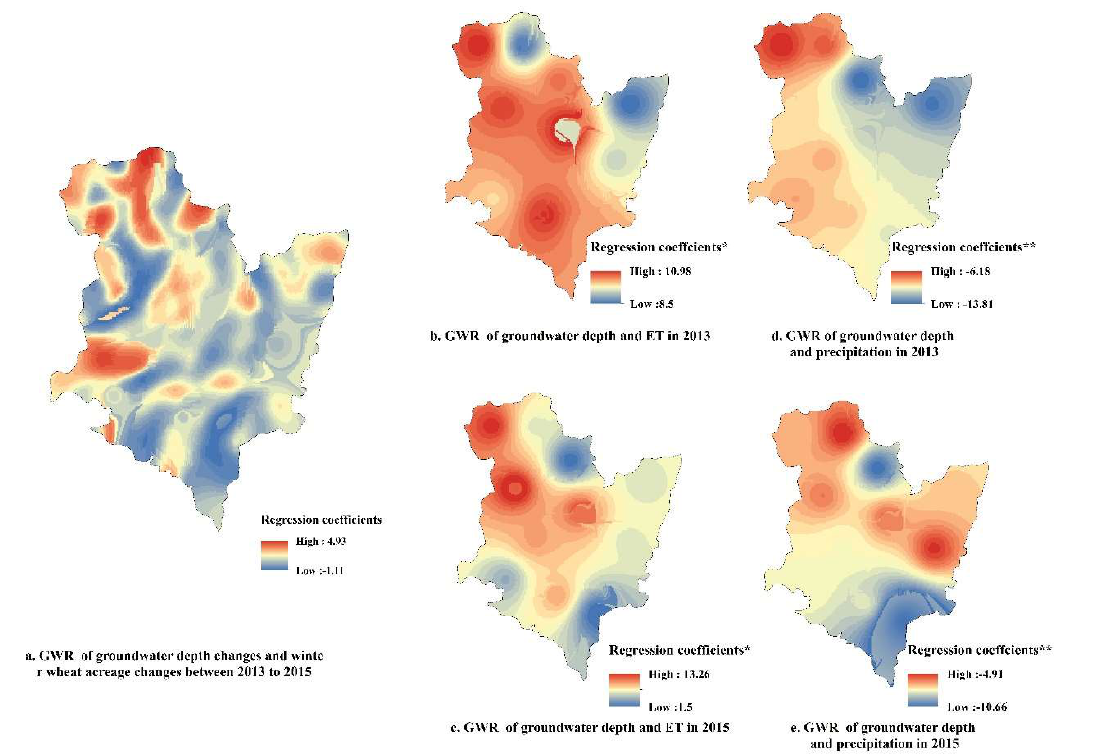
Figure 9. GWR analysis of shallow groundwater depth and influencing factors between 2013 and 2015. Local R 2 is mean local coefficient of determination after GWR. *** indicates values significant at p < 0.01; ** indicates values significant at p < 0.05; * indicates values significant at p < 0.1.